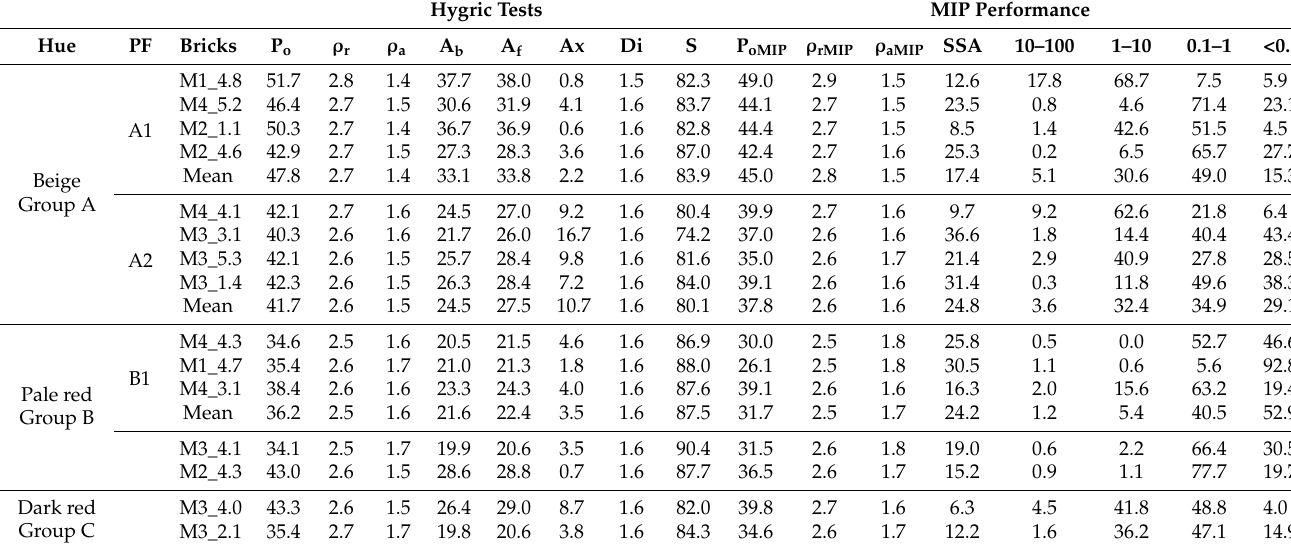
Table 3. Hygric parameters and MIP results on the brick tested. Open porosity (%) and apparent and real density (g/cm 3 ) determined both by hygric tests and MIP (P o and P oMIP , ρ r and ρ rMIP , ρ a and ρ aMIP ). A b (%) = free water absorption; A f (%) = forced water absorption; A x = degree of pore interconnection; Di = drying index; S (%) = saturation coefficient. SSA (m 2 /g) = specific surface area, percentage of pores comprised between 10 µ m and 100 µ m, 1–10 µ m, 0.1–1 and lower than 0.1 µ m determined by MIP. Means values of these parameters for petro-fabrics (PF) A1, A2 and B1 are also